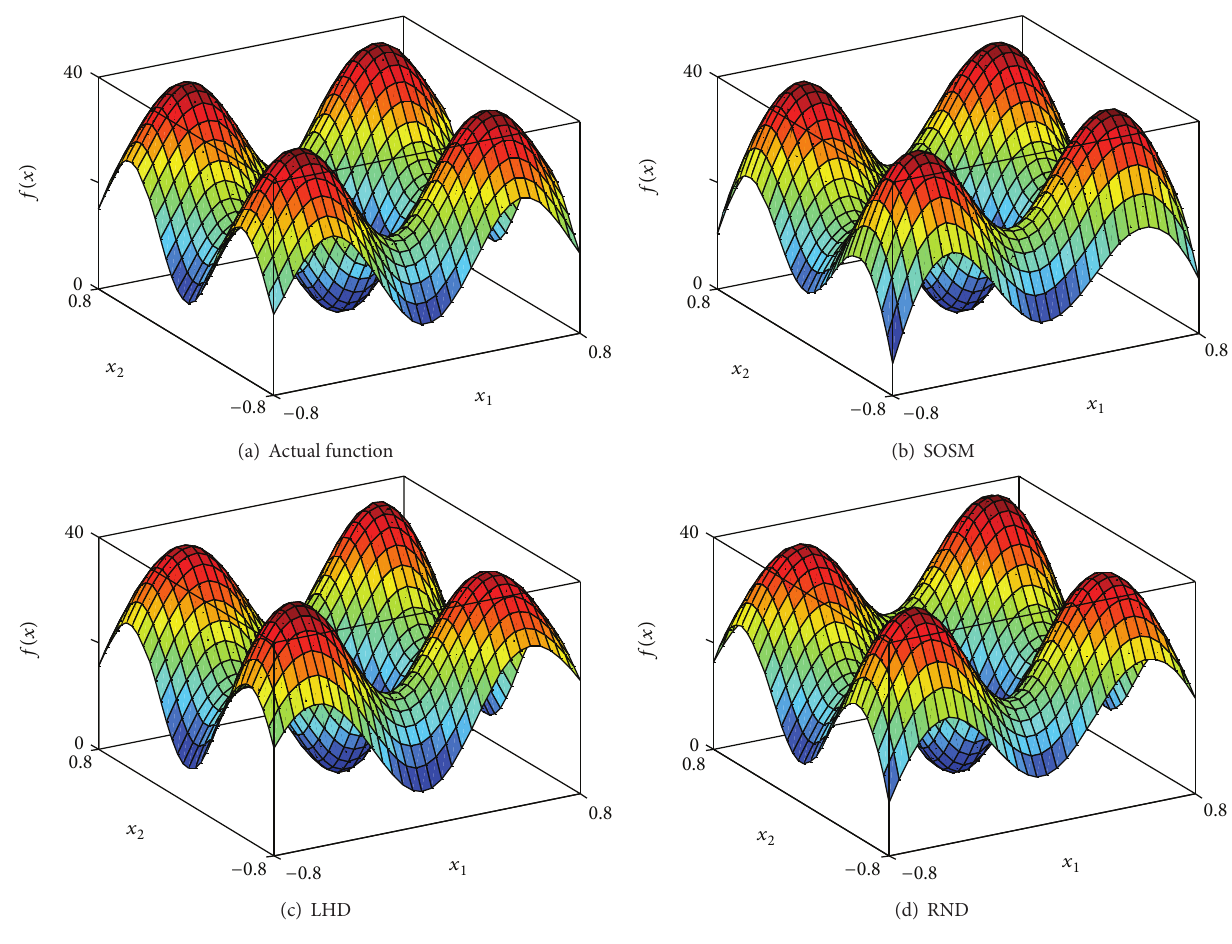
Figure 13: Function 3: actual and metamodel surface. Table 5: Metamodel accuracy results for functions 1–6 between SOSM and previous sequential sampling